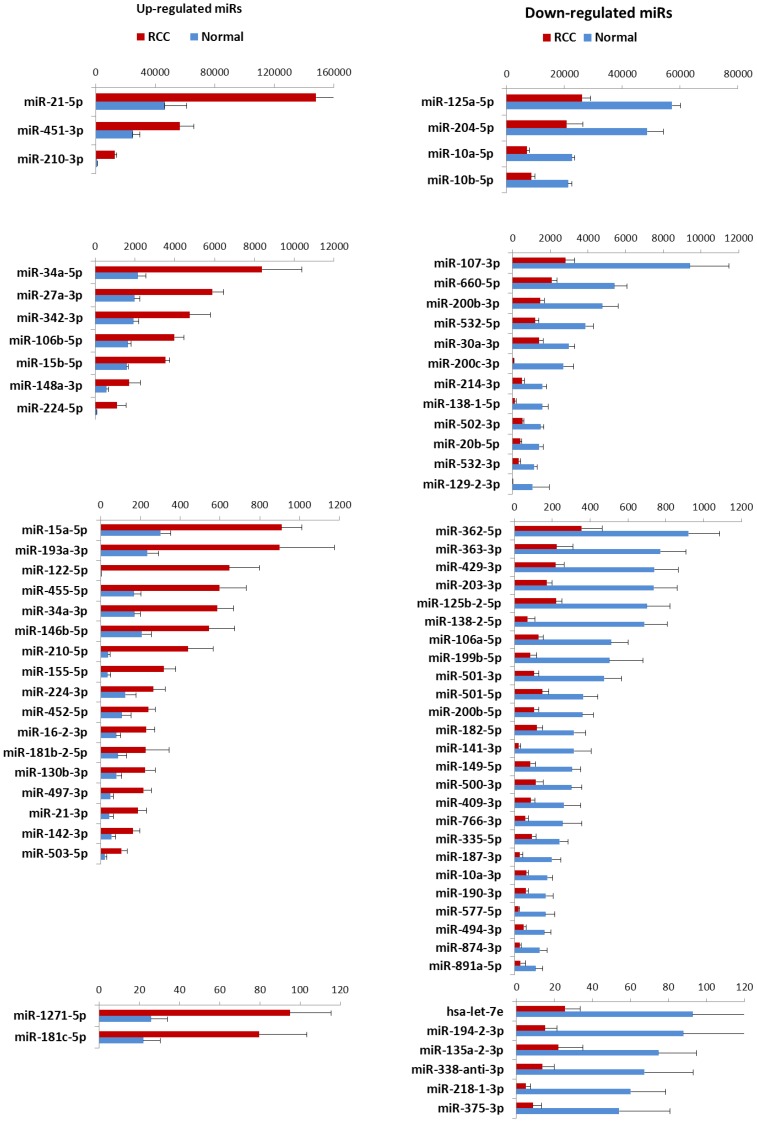
Differentially expressed miRNAs in ccRCC tumors.Differentially expression was analyzed between 11RCC tumors and their matched 11 normal kidney tissues. Significance was determined by adj. P value <0.05 using edgeR package. Differentially expressed miRNAs categorized into four categories based on level of expression. Expression levels are given as Mean ±SD. In the left panels (A-D) overexpressed miRNAs are shown, each panel representing a 10-fold difference in expression level. In the right panels (E-H), downregulated miRNAs are depicted with a 10-fold difference in maximal miRNA expression in normal tissue in each panel.